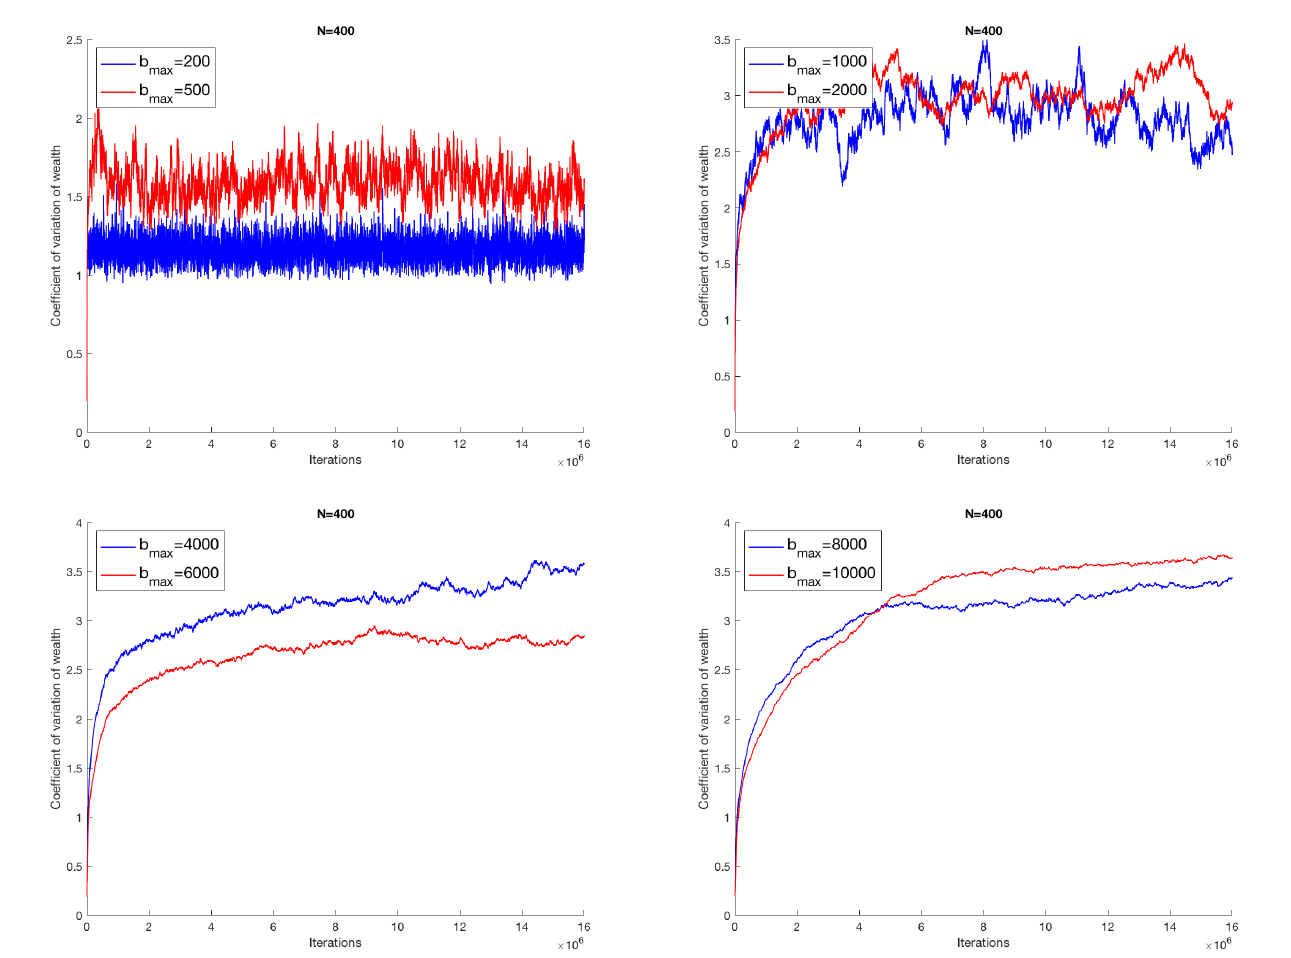
Figure 4. Plot of the coefficient of variation of the amount of money of the economic agents as transactions go on for N = 400 and b max = 200,500 ( top left ), b max = 1000,2000 ( top right ), b max = 4000,6000 ( bottom left ), b max = 8000, 10,000 ( bottom right ). The number of successful transactions is 100 N 2